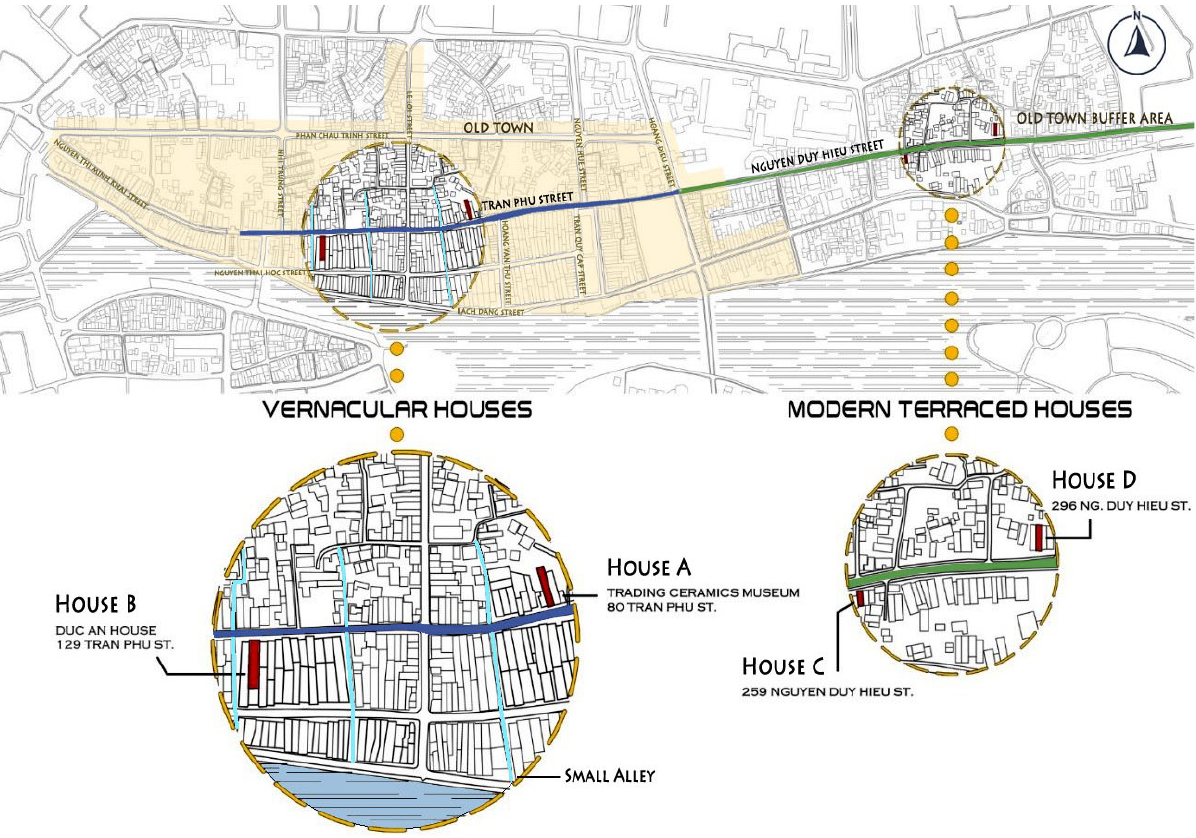
Figure 2. Diagram of research